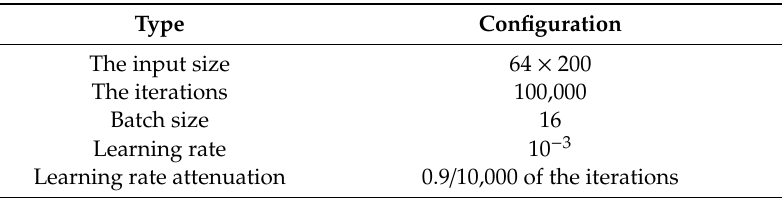
Table 3. Parameter settings